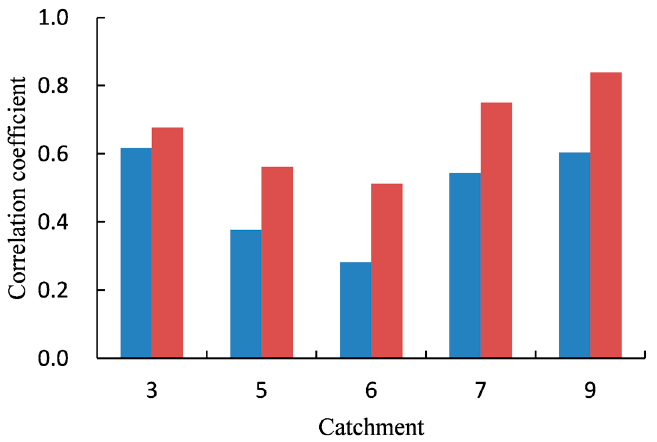
Figure 3. Correlation between summer precipitation (July–September) and the following winter discharge (December–February) for the period before 1985 (blue) and after 1985 (red). The catchments with short discharge records were not analyzed, such as catchment 1, 2, 4 and 8. Catchment 10 was not considered due to complete cessation of winter discharge from 1986 to 2013. The correlation coefficients were calculated by linear least square regression. See Table 1 for station/catchment information.